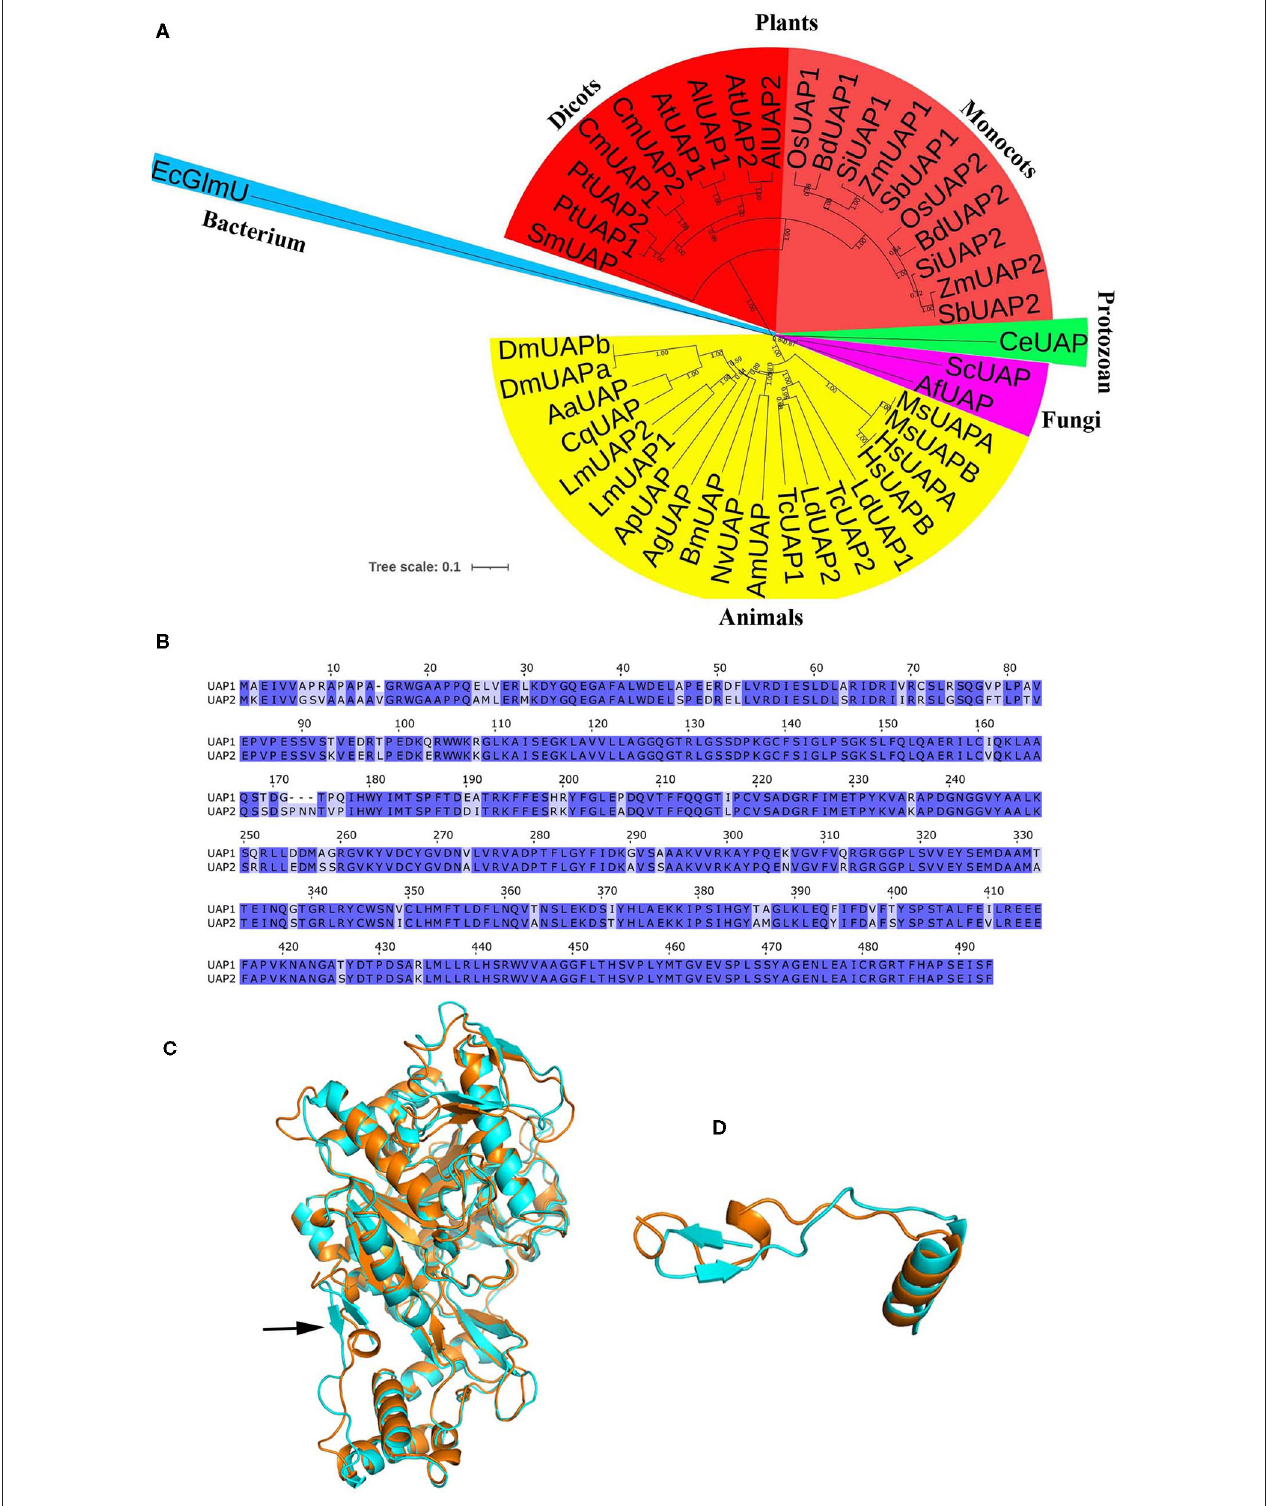
FIGURE 2 | Bioinformatic analysis of UAP proteins. (A) Phylogenetic analysis of UAPs in different organisms. The tree was constructed based on the full-length amino acid sequences of UAPs. The tree scale indicates the units of amino acid substitutions per site. GenBank accession numbers are as follows: SmUAP, Selaginella moellendorffii (XP_024532253.1); PtUAP1, Populus trichocarpa (XP_006369047.1); PtUAP2, Populus trichocarpa (XP_002303345.3); CmUAP1, Cucurbita moschata